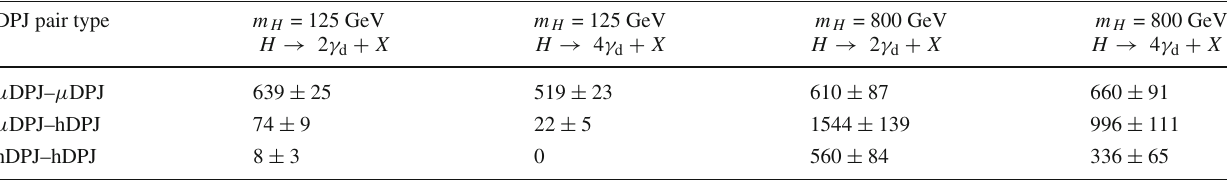
Table 5 Expected numbers of signal events in region A. A branch- ing fraction value of B ( H → f d production in the decay of the m H = 125 GeV Higgs boson. For DPJ